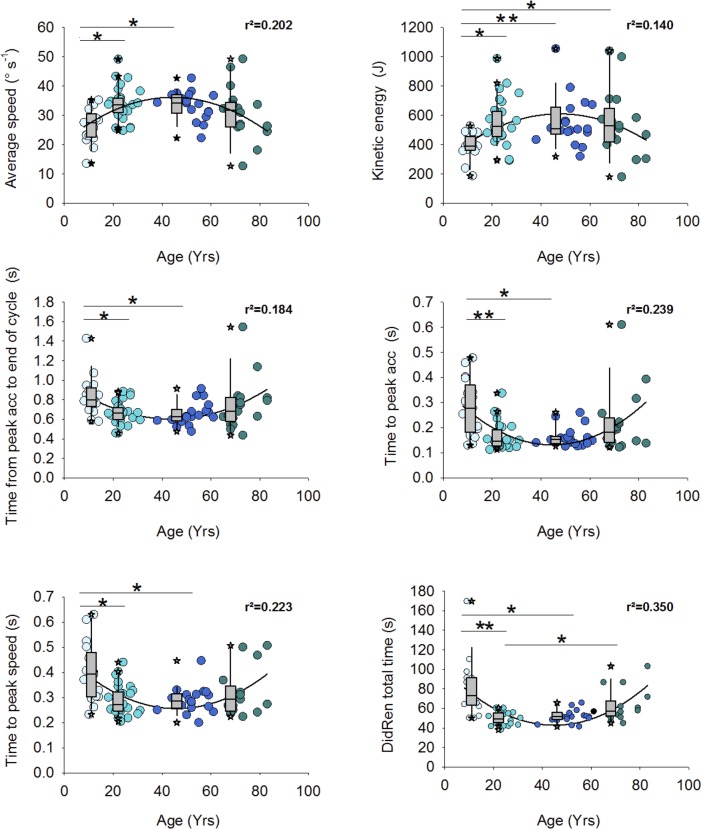
Box-plots and individual results for significant variables according to the different age-groups.Temporal performance (DidRen total time) and head-neck complex dynamics are represented as function of age and significant post hoc comparisons: * p<0.05; ** p<0.001. Second order polynomial regression curves (solid lines) were fitted across all data using the method of least squares.